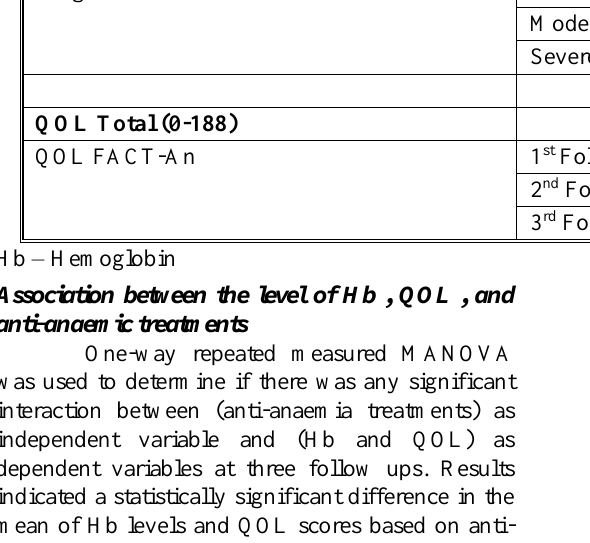
Table 3. Association between anti-anaemic medications and Hb level + QOL at 3 follow ups